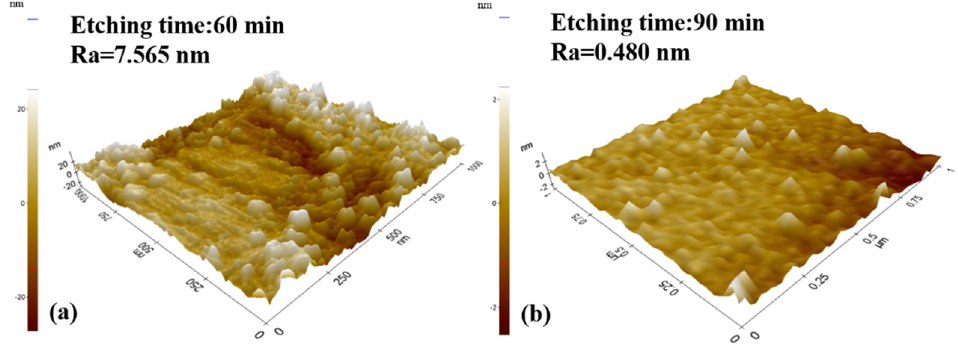
Figure 5. AFM images of the etched surface: ( a ) etching 60 min and ( b ) etching 90 min.